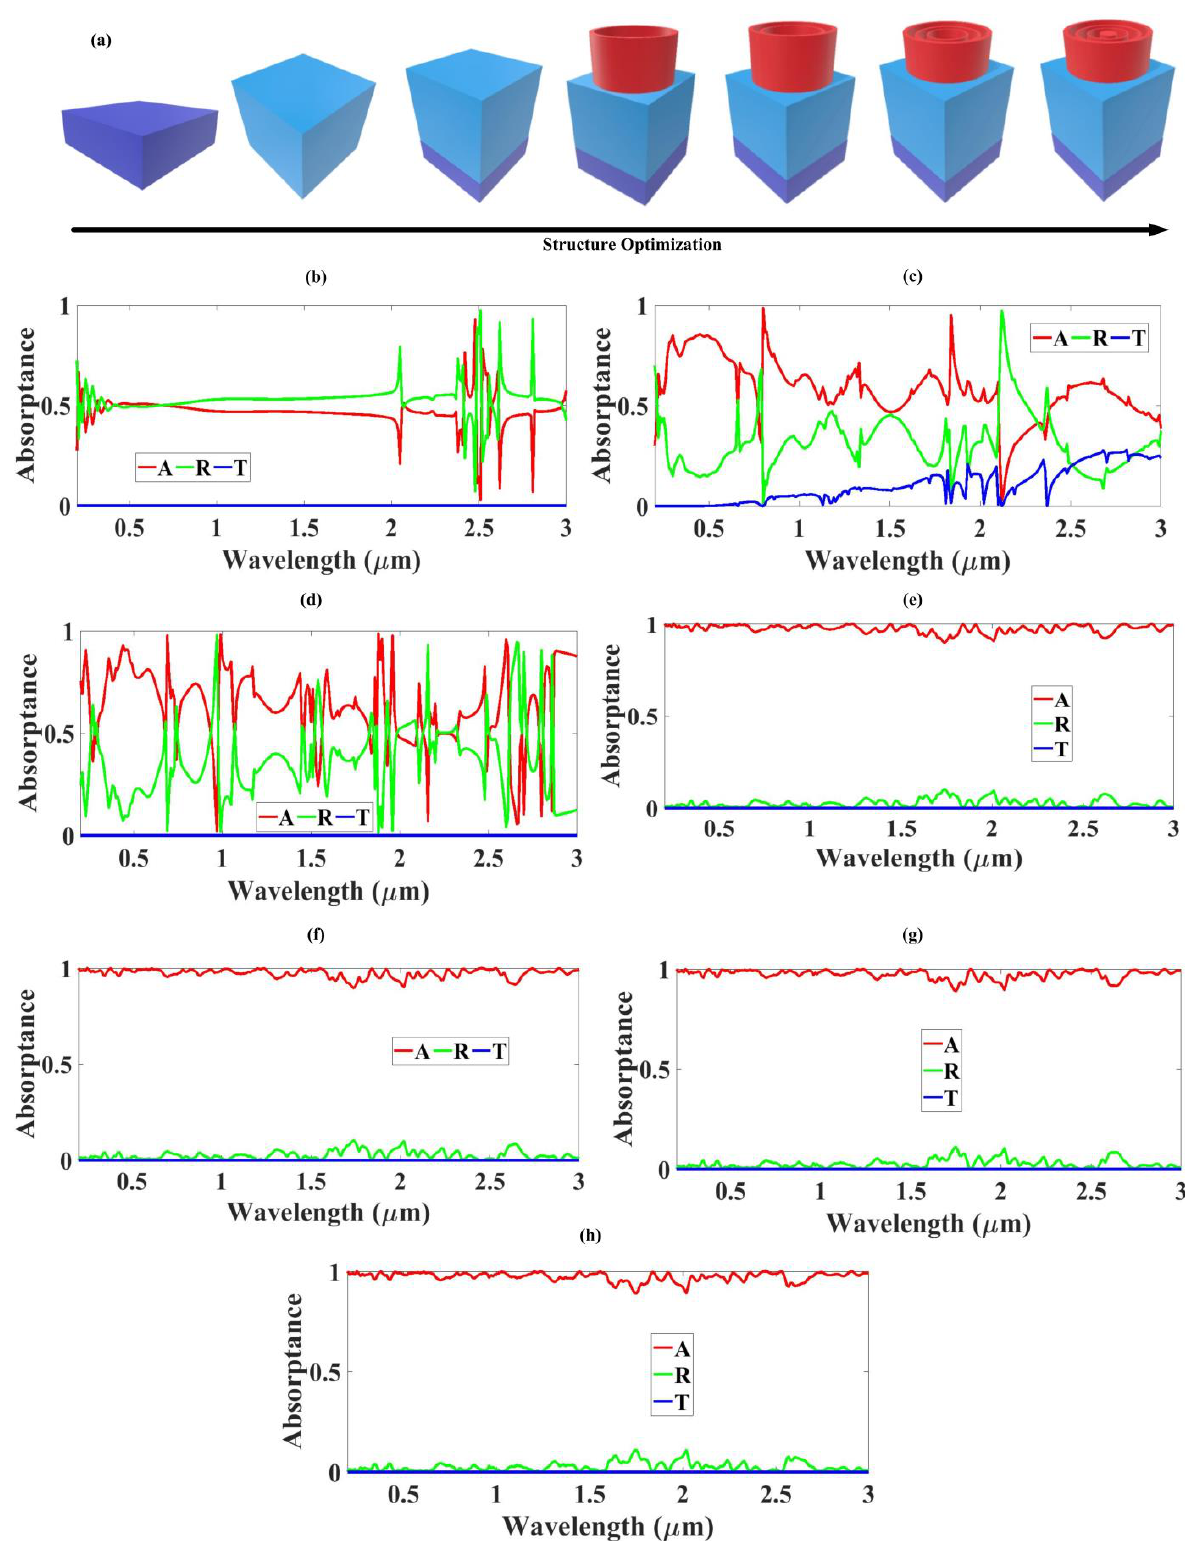
Figure 3. ( a ) Construction for the GST ring resonator configuration process step by step, ( b ) absorp- tance (A), reflectance (R), and transmittance (T) lines for the Cr ground layer, ( c ) A, R, and T lines for the SiO 2 layer, ( d ) A, R, and T lines of the construction of both the Cr ground layer and SiO 2 layer, ( e – h ) A, R, and T lines by inserting the first GST ring resonator, second GST ring resonator, third GST ring resonator, and the cylinder constructed on the Cr ground layer, and SiO 2 layer